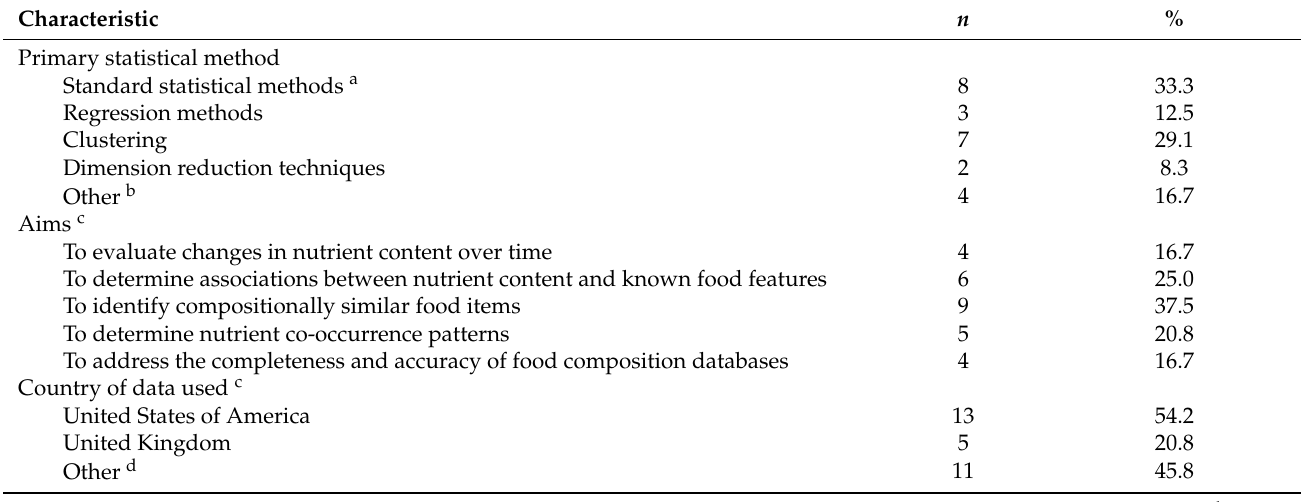
Table 2. Characteristics of included studies ( n =